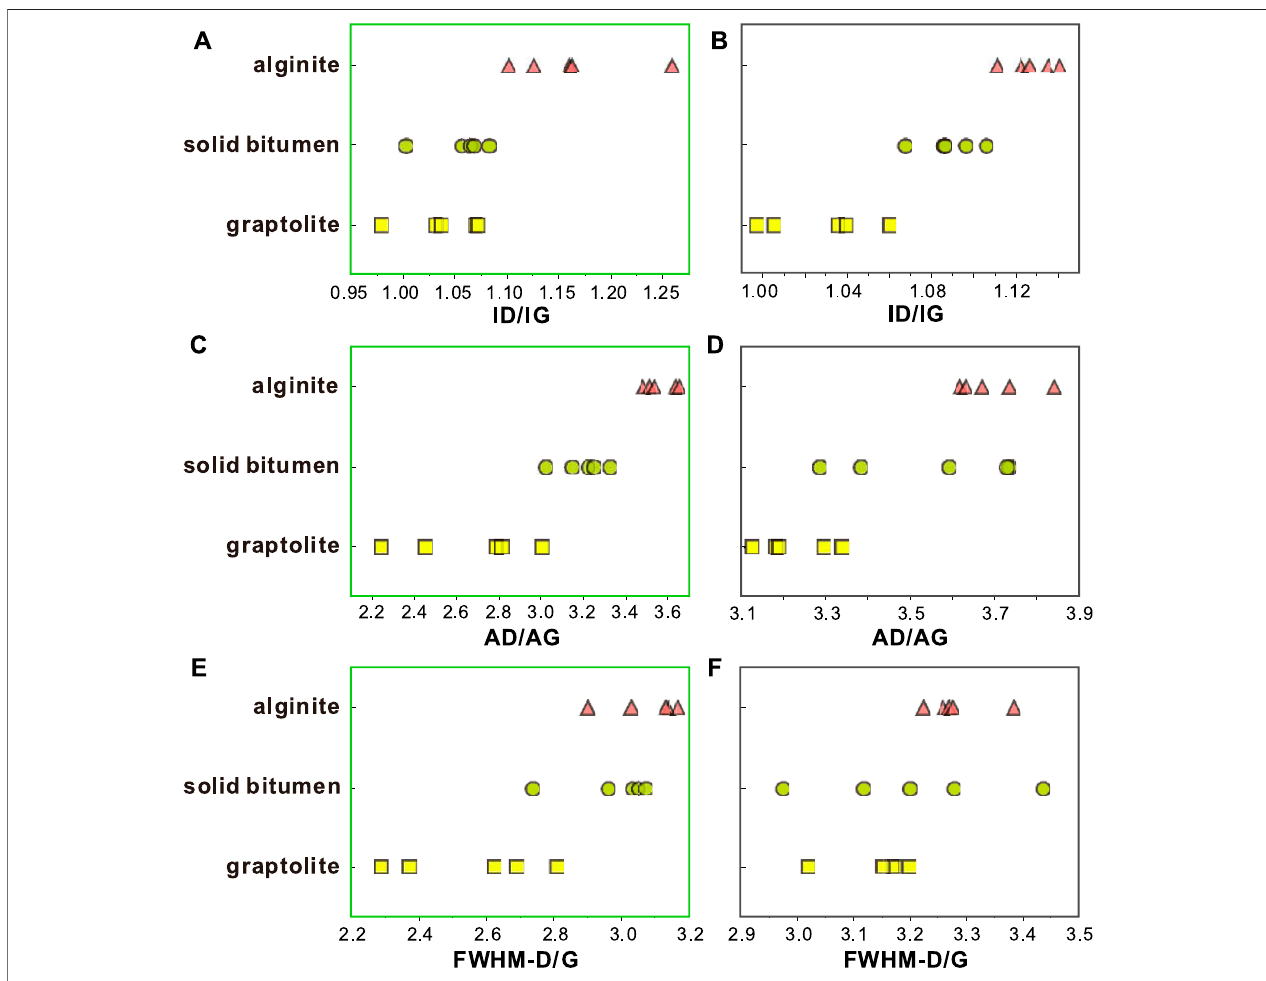
FIGURE 8 | Raman structural parameters of three macerals in jy2 HF (left) and ys118 (right) samples.